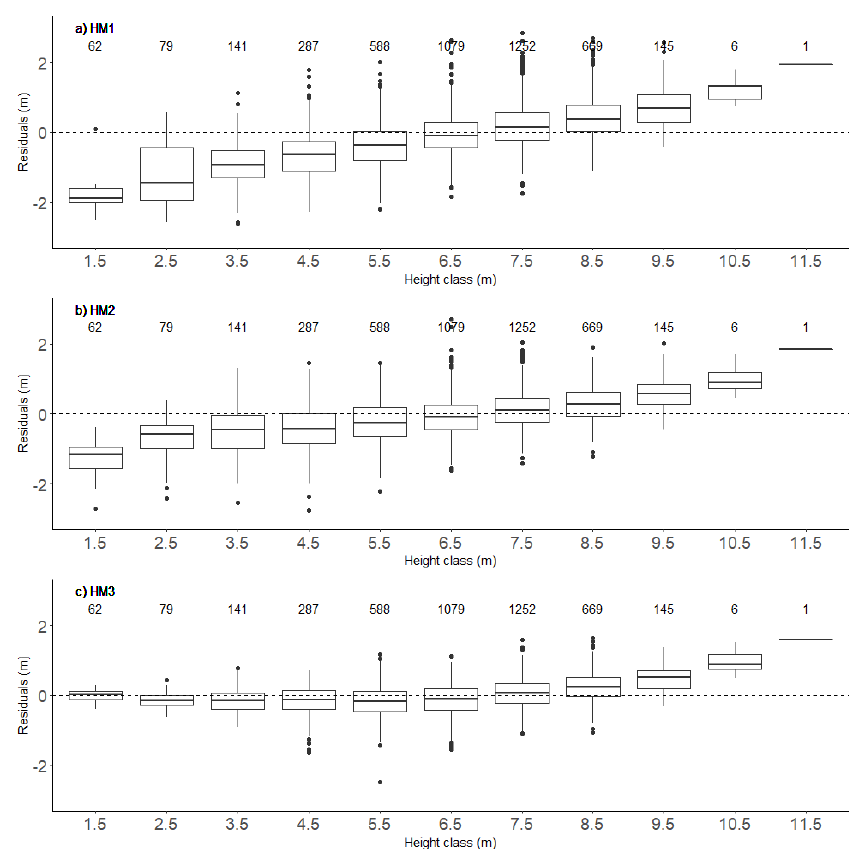
Figure 4. Box-plots of residuals (measured—estimated heights) for the three height models (HM1—( a ), HM2—( b ) and HM3—( c )) in 10 dm height classes. Values above the boxes are the numbers of trees in the corresponding height classes.